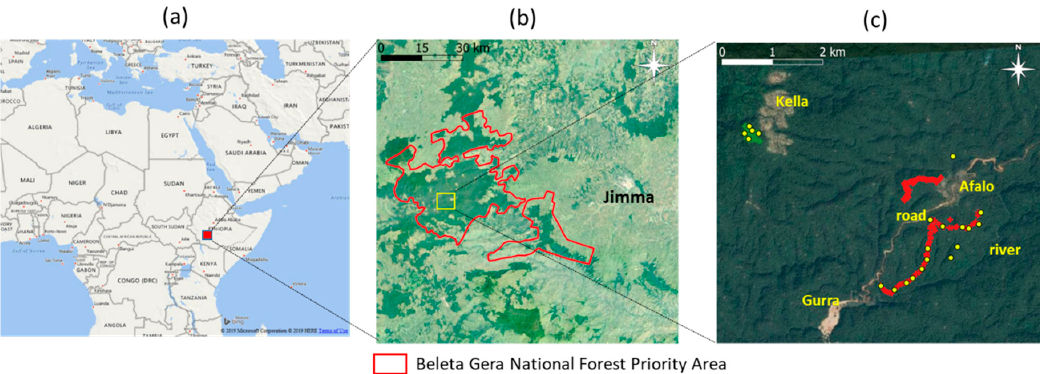
Figure 1. Map of the study area and surrounding region. ( a ) Northeastern Africa, ( b ) Belete-Gera National Forest Priority Area, and ( c ) study area (green crosses: natural forest (NF) canopy photography survey sites near Kella; red crosses: heavily managed co ff ee forest (HMCF) canopy photography survey sites near Afalo and Gurra; yellow dots: tree biodiversity survey site). In ( c ), three local villages (“Afalo”, “Kella”, and “Gurra”) are shown with the road connecting Afalo and Gurra, and the river in the